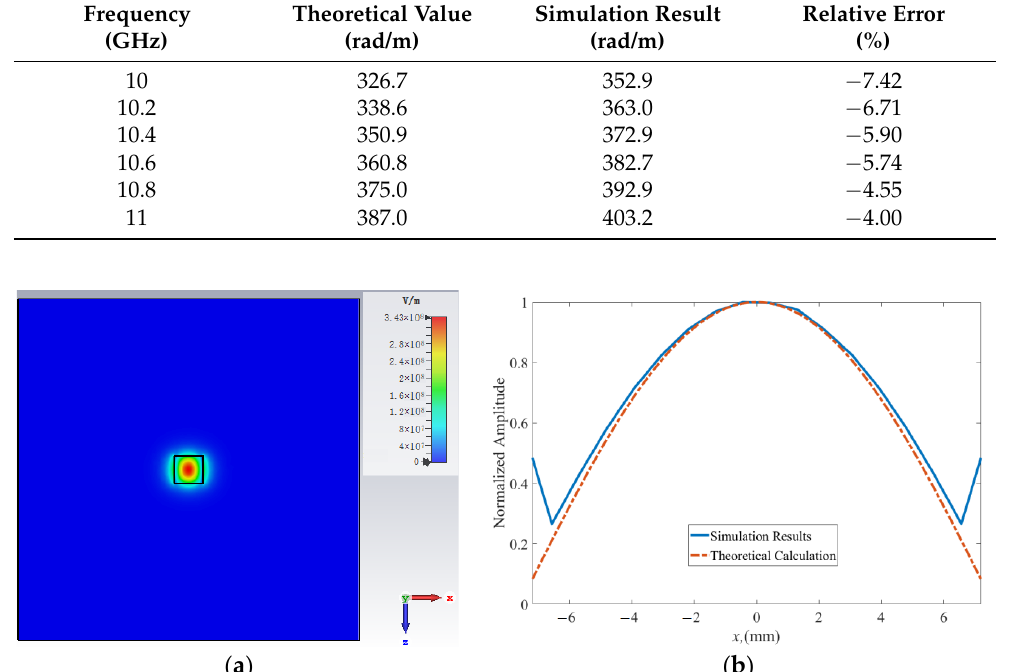
Figure 7. Field distribution of the lowest guided mode in cross-plane ( a ) field distribution from CST simulation ( b ) simulated and calculated field strengths along x axis. Table 1. Theoretical and simulated real parts of longitudinal phase constants for guide mode.